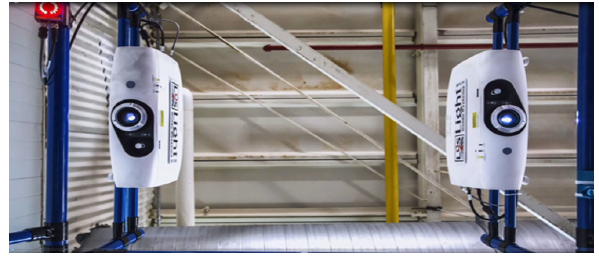
Figure 4: Projectors of the system of Video-mapping.